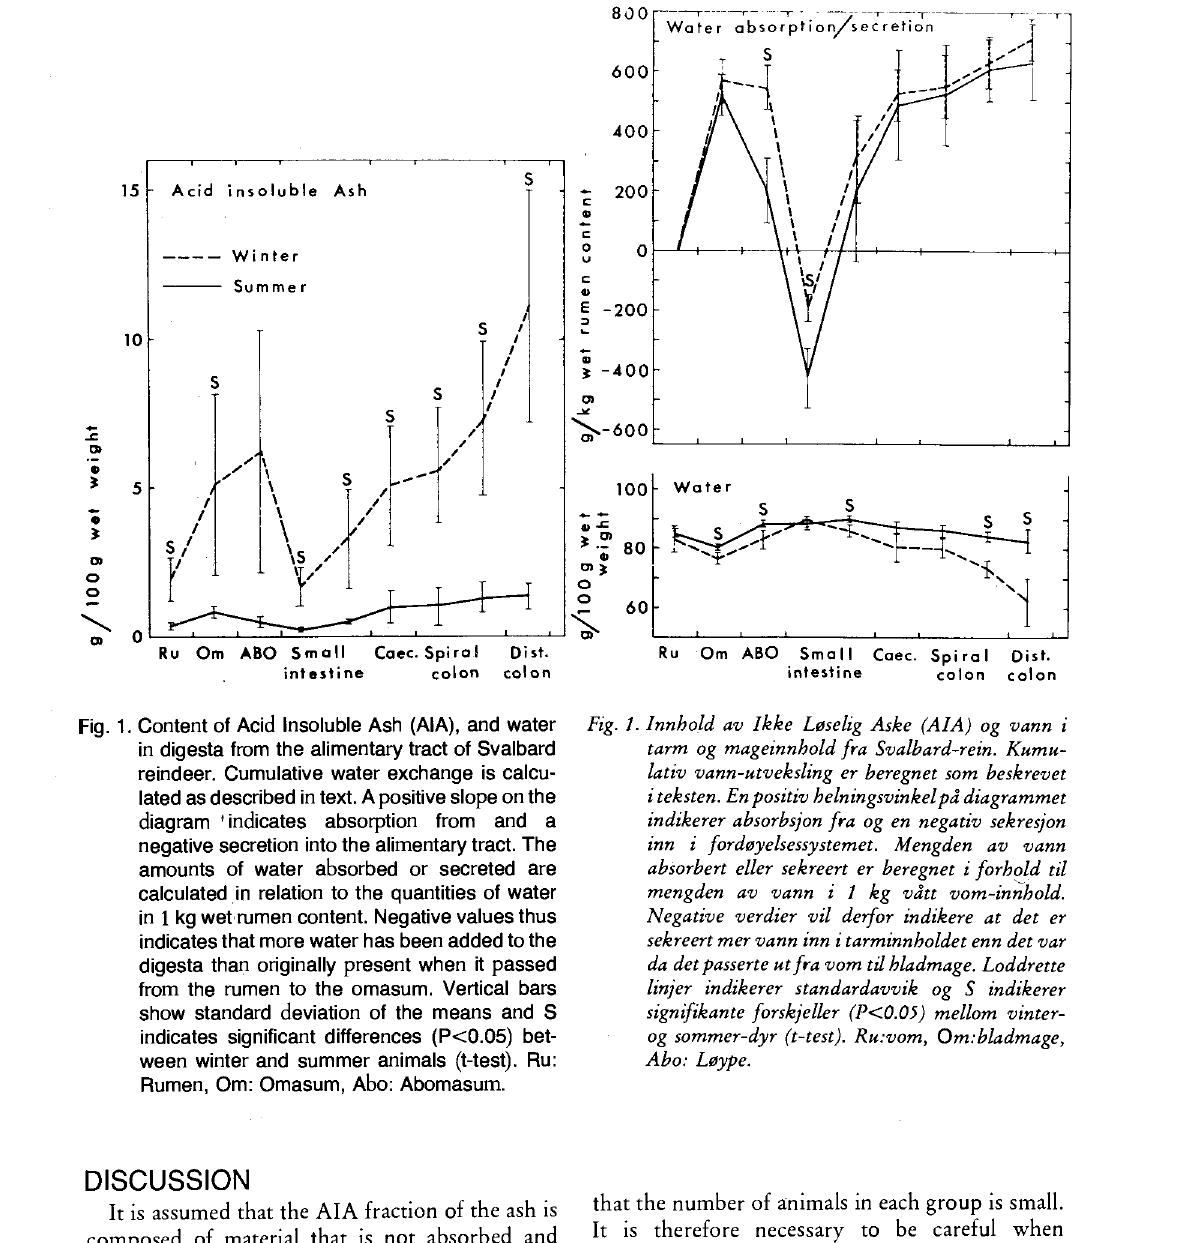
Fig. 1. Innhold av Ikke Løselig Aske (AIA) og vann i tarm og mageinnhold fra Svalbard-rein. Kumu lativ vann-utveksling er beregnet som beskrevet i teksten. En positiv helningsvinkel pd diagrammet indikerer absorbsjon fra og en negativ sekresjon inn i fordøyelsessystemet. Mengden av vann absorbert eller sekreert er beregnet i forhold til mengden av vann i 1 kg vått vom-innhold. Negative verdier vil derfor indikere at det er sekreert mer vann inn i tarminnholdet enn det var da det passerte ut fra vom til hladmage. Loddrette linjer indikerer standardavvik og S indikerer signifikante forskjeller (P<0.05) mellom vinter- og sommer-dyr (t-test). Ru:vom, Om:bladmage, Abo: